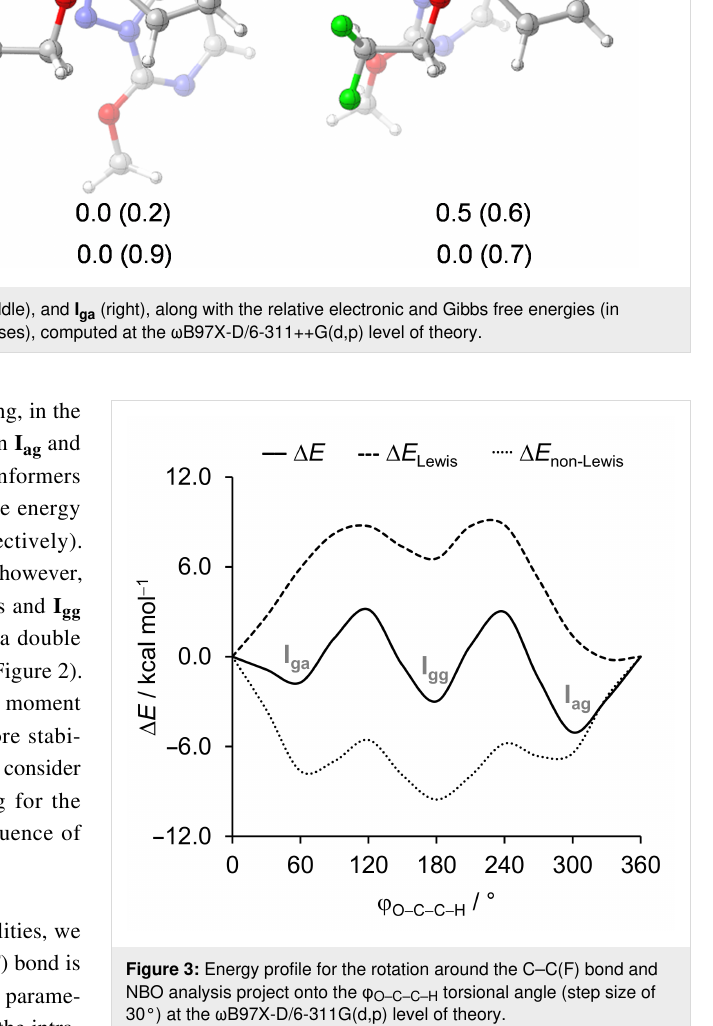
Figure 3: Energy profile for the rotation around the C–C(F) bond and NBO analysis project onto the φ O–C–C–H torsional angle (step size of 30°) at the ω B97X-D/6-311G(d,p) level of